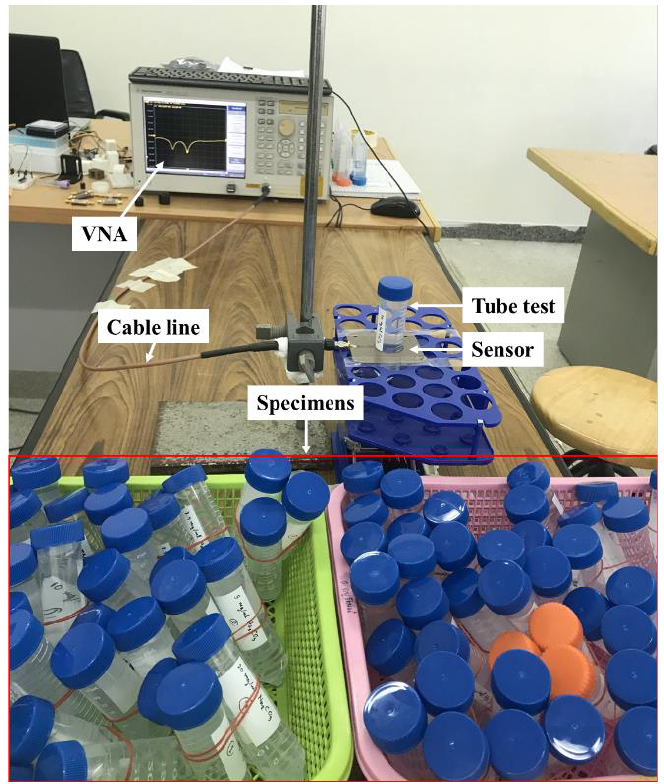
. Figure 2. The experimental